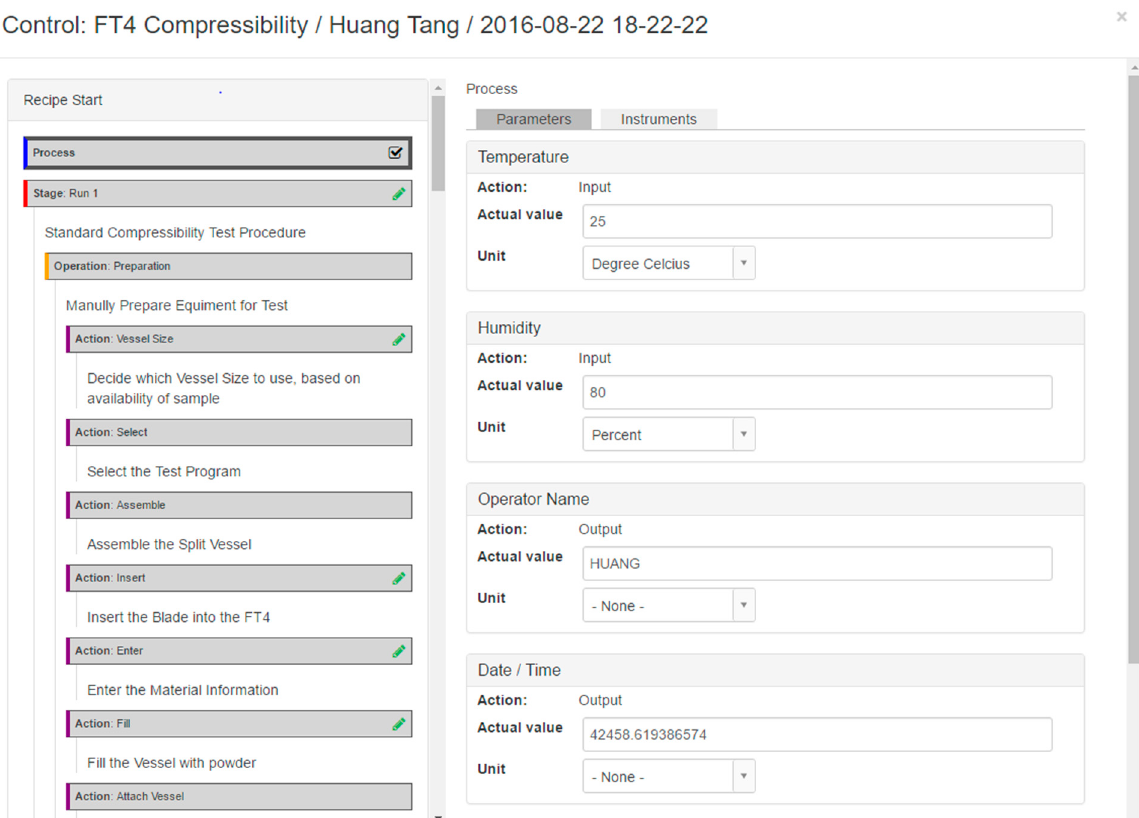
Figure 17. Execution dialog of control recipe.